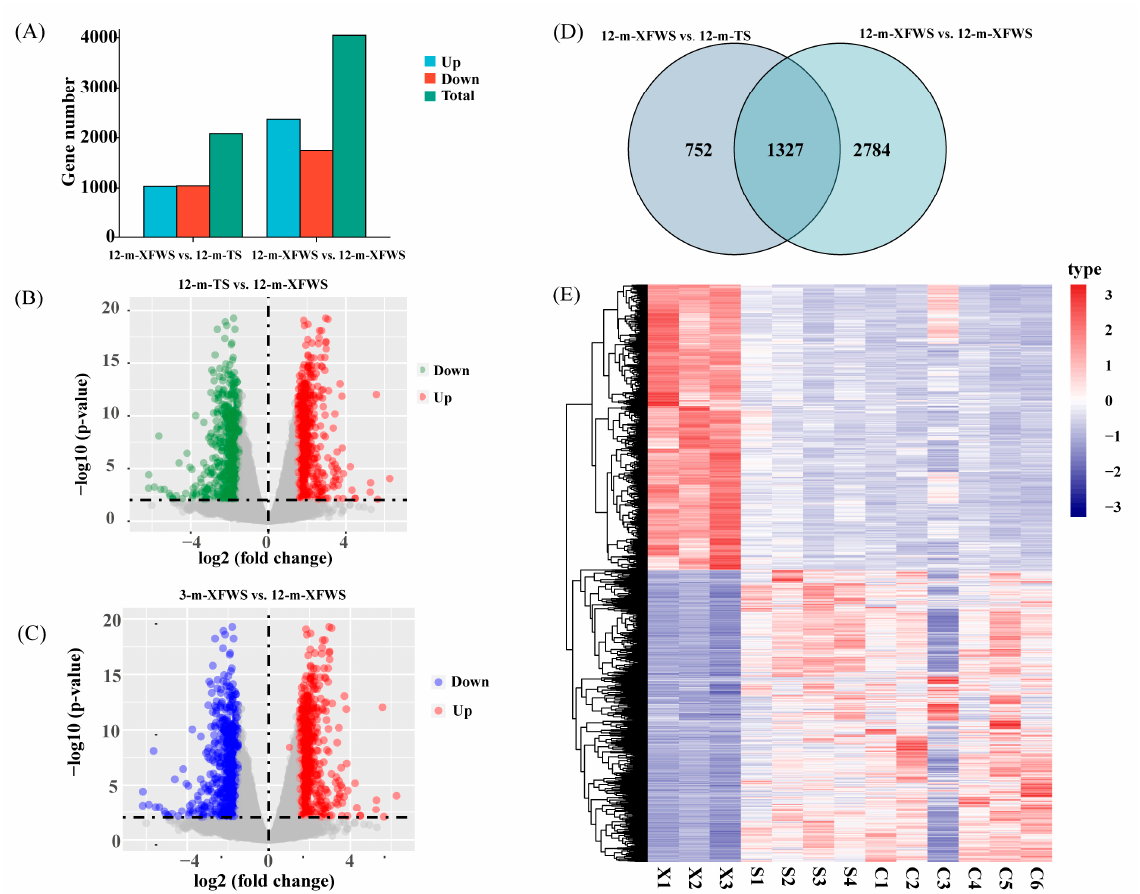
Figure 2. Gene expression characterization in the skin of Xinji fine-wool sheep at 3 and 12 months of age and Tan sheep at 12 months of age. ( A ) The number statistics of upregulated and downregulated DEGs (DEGs, differentially expressed genes). ( B , C ) A volcano plot of DEGs in different breeds and ages. ( D , E ) Venn diagram and heat map of overlapped DEGs at different breeds and growth stages.